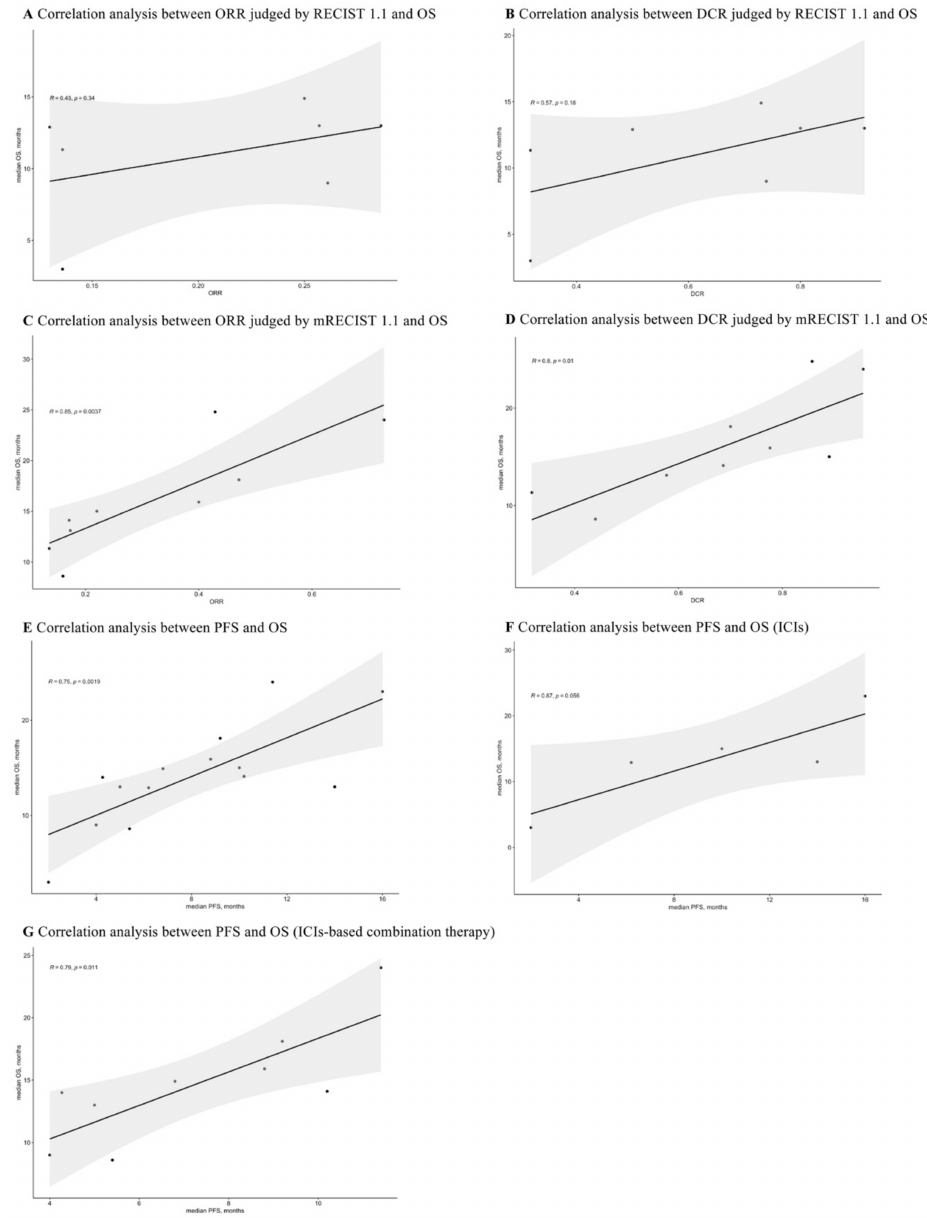
Figure 9. Correlation analyses between ORR, DCR, PFS, and